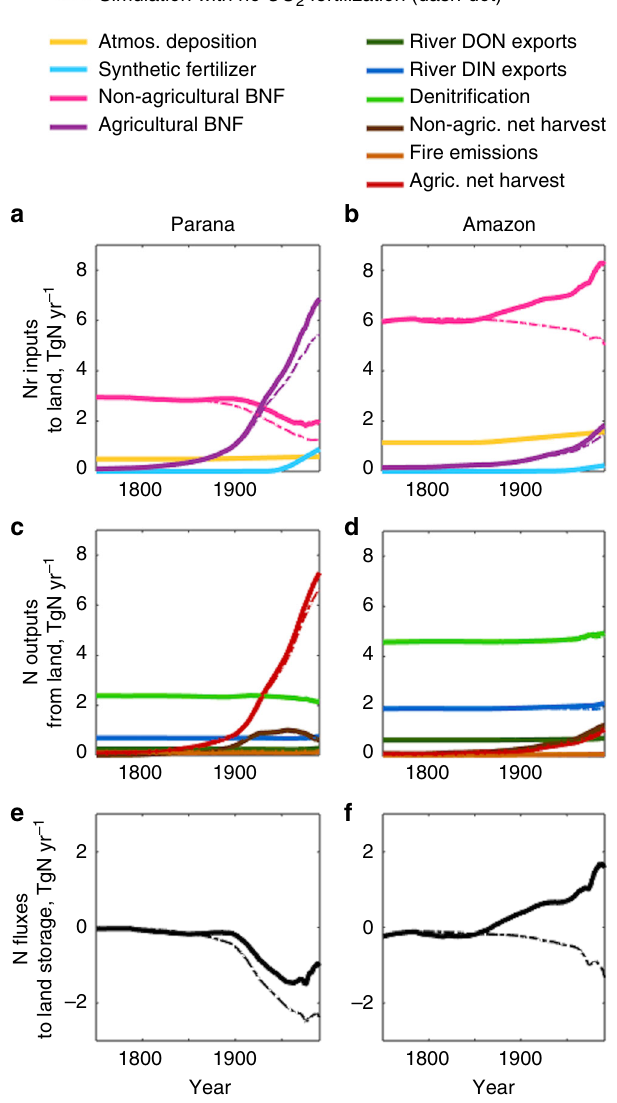
Fig. 7 Land N fl uxes in the Amazon and Parana Basins. a , b Land Nr inputs include atmospheric deposition (light orange), synthetic fertilizers (sky- blue), biological N fi xation (BNF) in non-agricultural (plum) and agricultural (purple) lands. c , d Land N outputs include river dissolved organic N (DON) exports (green), river dissolved inorganic N (DIN) exports (blue), soil and freshwater denitri fi cation (light green), fi re emissions (orange), net harvest in agricultural (red) and non-agricultural (brown) lands. e , f N fl uxes to land storage. Solid thick lines show the baseline simulation. Dash-dot thin lines show the no-CO 2 fertilization simulation. All plots show 30-year moving averages from 1750 to